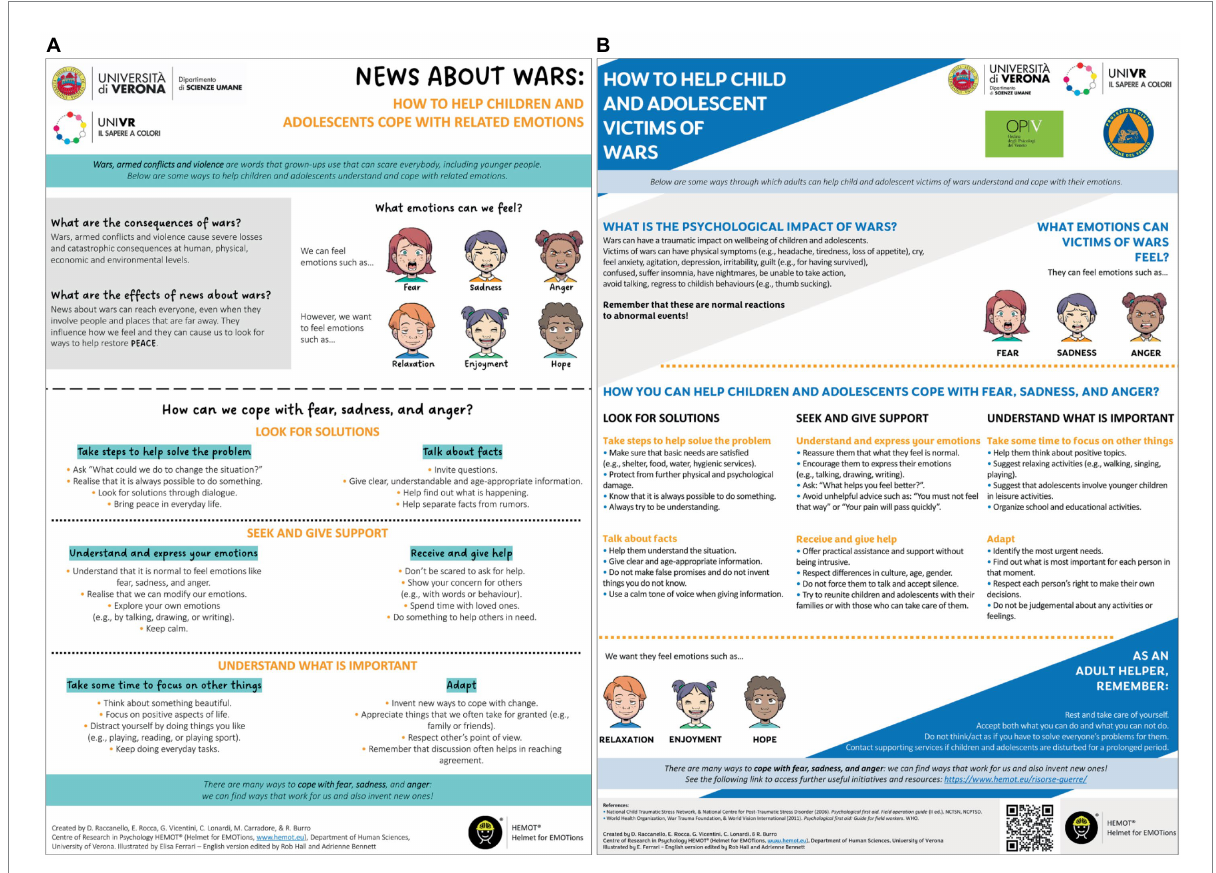
FIGURE 1 The English version of (A) the pamphlet for supporting adults to help children and adolescents cope with news about wars, and (B) the pamphlet for supporting adults to help children and adolescent victims of